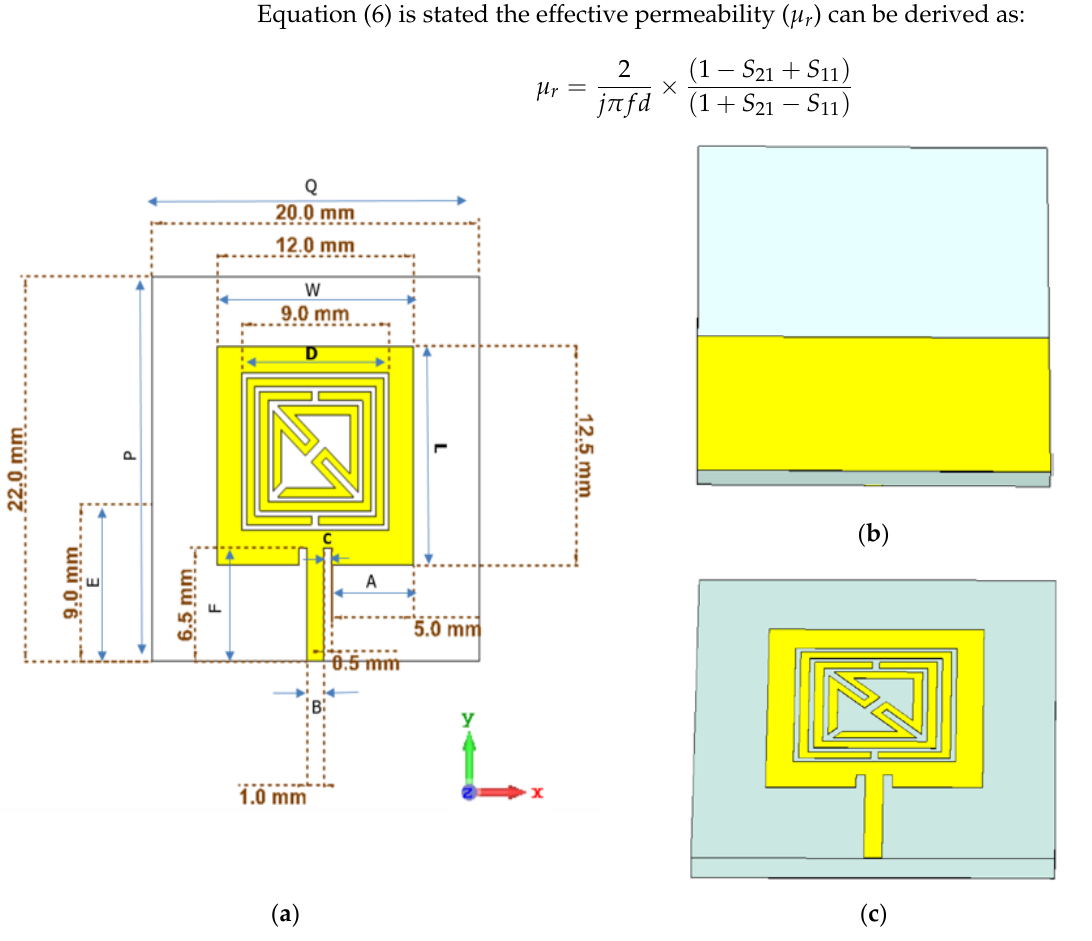
Figure 7. The design configuration with 2D layout ( a ); schematic view of back side ( b ) and front side ( c ) of the proposed metamaterial-based sensor.